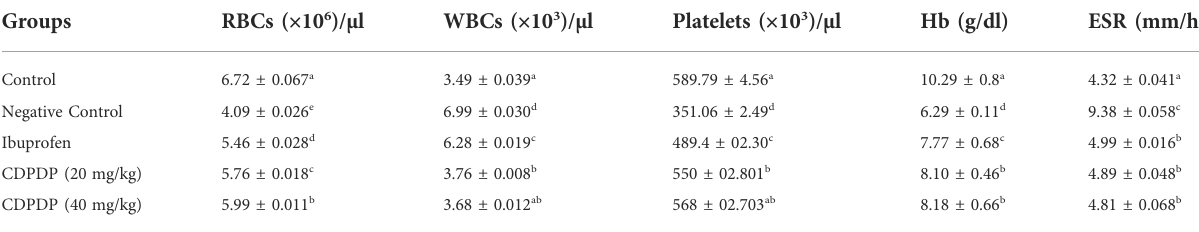
TABLE 4 The hematological examination of normal control besides arthritic